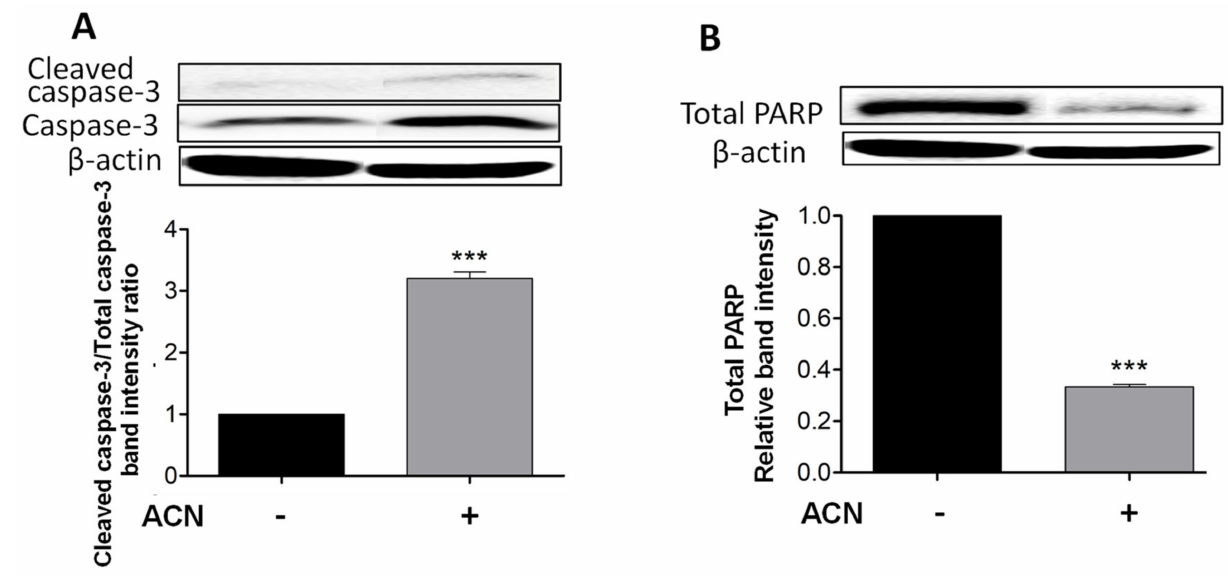
Figure 2. ACN induced apoptosis in 4T1 BC cells through a caspase-dependent pathway. Cleaved and total caspase-3 protein levels and ratio of cleaved caspase-3 to total caspase-3 ( A ). Total PARP protein levels ( B ). Cells starved overnight were treated with ACN (IC 50 ) in 2.5% FBS supplemented culture medium for 48 h. Cell lysates were subjected to immunoblot analysis with primary and secondary antibodies as detailed in materials and methods. Western blots are representative of at least two independent experiments (upper panels). Band intensities of target proteins determined with ImageJ software were divided by band intensity of β -actin, and values were normalized to untreated control (lower panels). Data from relative band intensity are mean ± SEM. The unpaired t test with Welch’s correction was used to determine significance (*** p <